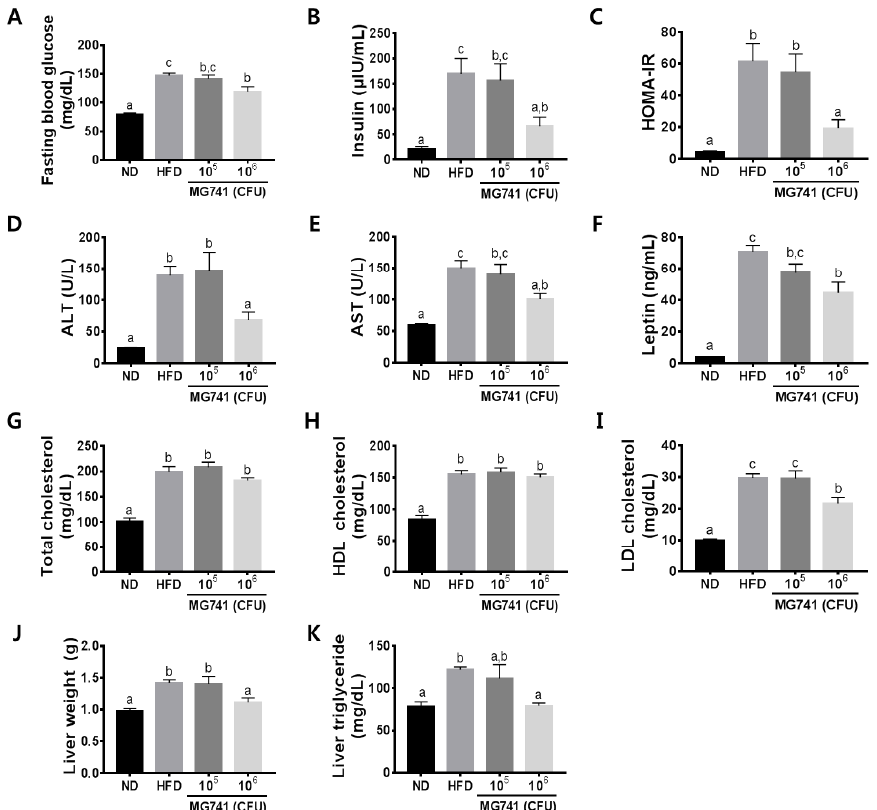
Figure 2. Bifidobacterium animalis ssp. lactis MG741 (MG741) ameliorates high-fat-diet-induced metabolic disorder parameters. ( A ) Fasting blood glucose; ( B ) insulin; ( C ) HOMA-IR; ( D ) serum ALT; ( E ) serum AST; ( F ) serum leptin; ( G ) serum total cholesterol; ( H ) serum HDL-cholesterol; ( I ) serum LDL-cholesterol; ( J ) liver weight; and ( K ) liver triglycerides. Data are presented as the mean ± standard error of the mean ( n = 9). The different letters (a–c) indicate significant differences ( p < 0.05) determined by one-way ANOVA with Tukey’s post hoc tests.